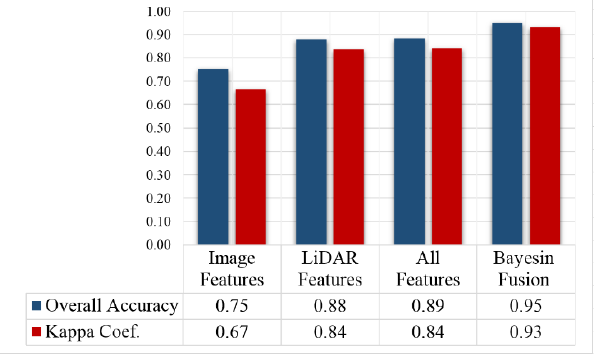
Figure 10. Comparison between classification